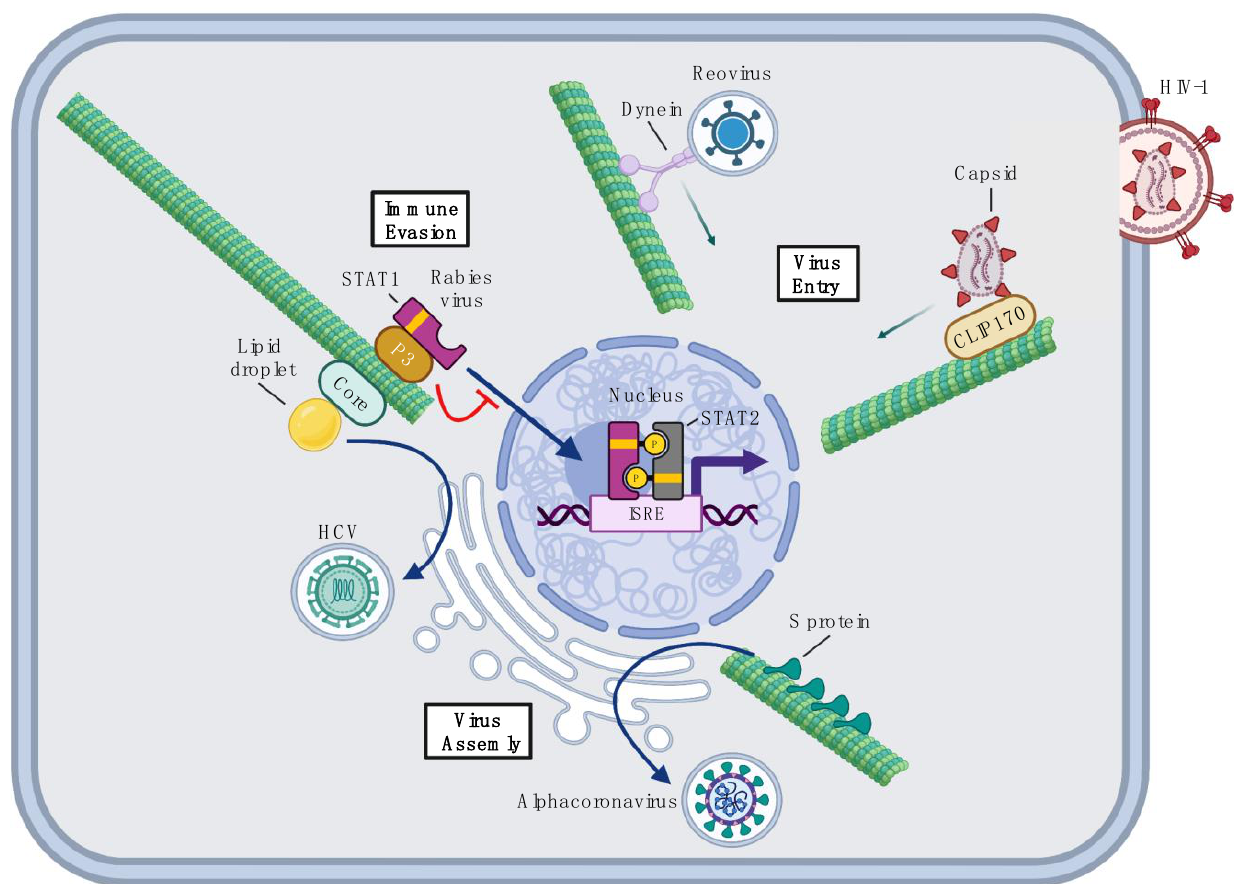
Figure 1. RNA virus and retrovirus interactions with MTs. Examples of how RNA viruses and retroviruses interact with, and manipulate, the MT network. Reovirus uses dynein motors to move towards perinuclear sites to initiate replication. Human immunodeficiency virus type 1 (HIV-1) capsid protein is a cellular MAP mimic that interacts with the cellular MAP CLIP170 to promote its transport to the nucleus via MTs. Hepatitis C virus (HCV) core protein is a MAP that facilitates lipid droplet transport used in virion assembly. Alphacoronavirus spike (S) protein – MT interaction is critical for S protein incorporation onto newly forming virions. Rabies virus evades immune responses by tethering STAT1 to MTs, blocking its association with STAT2 and its nuclear import to activate IFN pathway gene expression. ISRE, interferon-sensitive response element. Figure was created using Biorender.com (accessed on 3 May 2022).